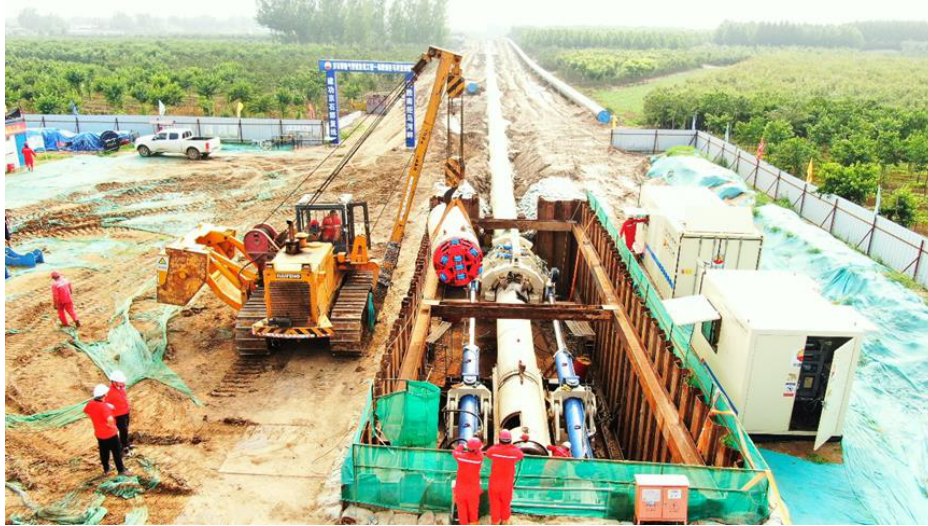
Figure 2. Figure of overall layout of construction site.